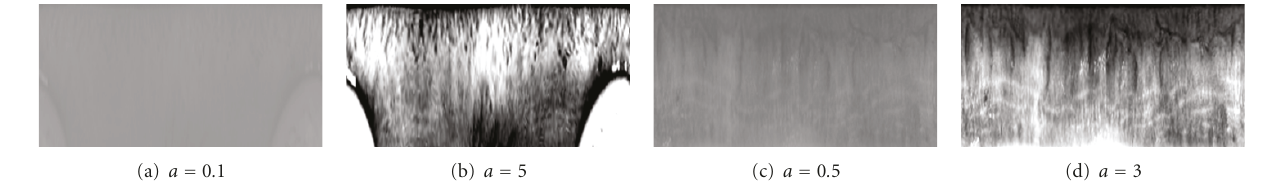
Figure 16: Examples of contrast variations. (a, b) CASIA image, (c, d) ISEP image.